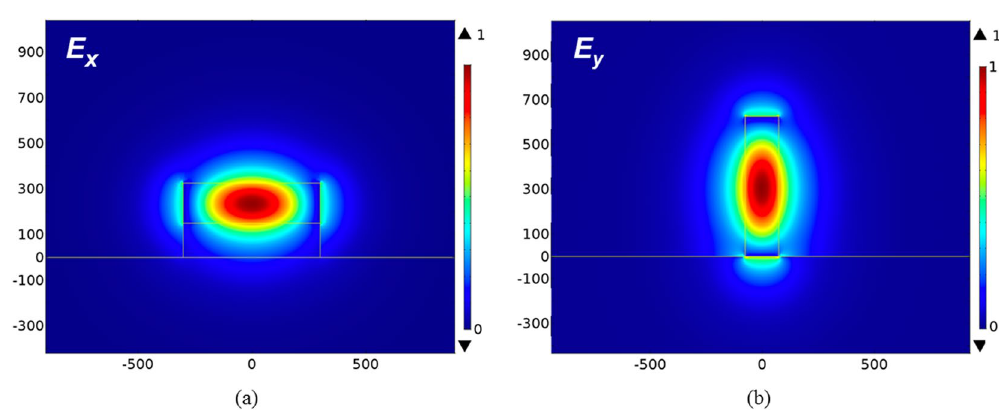
Figure 4. The guided mode profiles of the ( a ) TE mode (electric field component, E x ) at the TE outport and the ( b ) TM mode (electric field component, E y ) at the TM